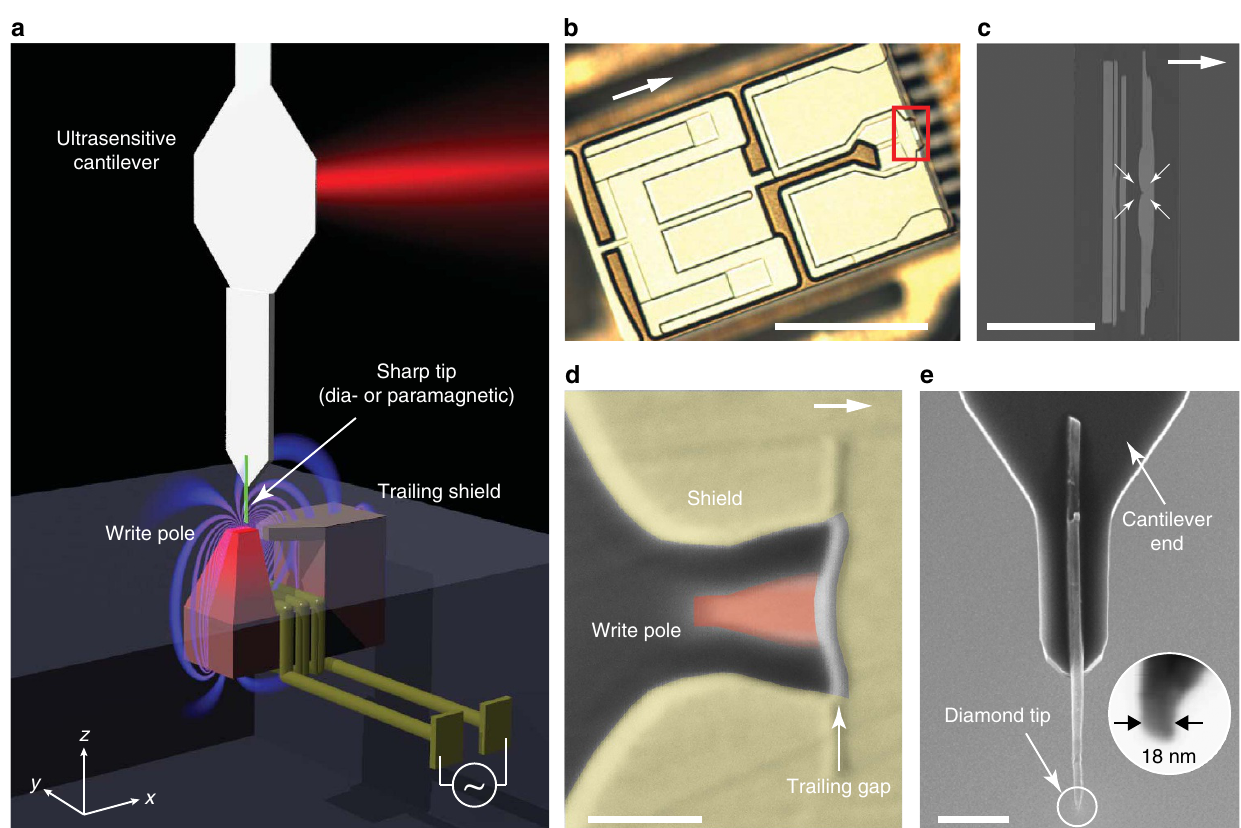
Figure 1 | Geometry of write head experiment and device. ( a ) A sharp diamond needle (green), attached to a nanomechanical force transducer, is positioned over the write pole of a magnetic recording head. An alternating current periodically switches the pole polarity and induces magnetic gradient forces through dia- or paramagnetism in the tip. Experiments are carried out in a custom scanning force microscope operating at 4K and in high vacuum. ( b ) Optical micrograph of the write head device. Arrows in b , c and d point in the direction of the trailing edge (in positive x direction). The write head was extracted from a commercial Seagate hard drive, reconnected to external leads and mounted in the apparatus as discussed in the Methods section. Scale bar, 0.5mm. ( c ) Zoom-in on the write/read region of the device. The write pole is at the centre of the four arrows. Scale bar, 20 m m. ( d ) The B 90 (cid:3) 60nm 2 write pole (red) is surrounded by a return shield (yellow) that serves to recollect the field lines. The gradient is largest in the B 20-nm-wide trailing gap between pole and shield. Scale bar, 100nm. ( e ) Diamond nanowire probe attached to the end of an audio frequency ( B 5kHz) silicon cantilever. Inset shows apex of tip B. Scale bar, 2 m | B | ¼ [ m 0 W /( w V )] 1/2 . We have quantitatively determined | B | and q x | B | for the force map of Fig. 4d by calibrating the magnitude of the force and the effective tip volume ( V eff ¼ 2.9 (cid:3) 10 (cid:2) 24 m 3 , tip B) (see Supplementary Figs 2–4 and Supplementary Notes 1